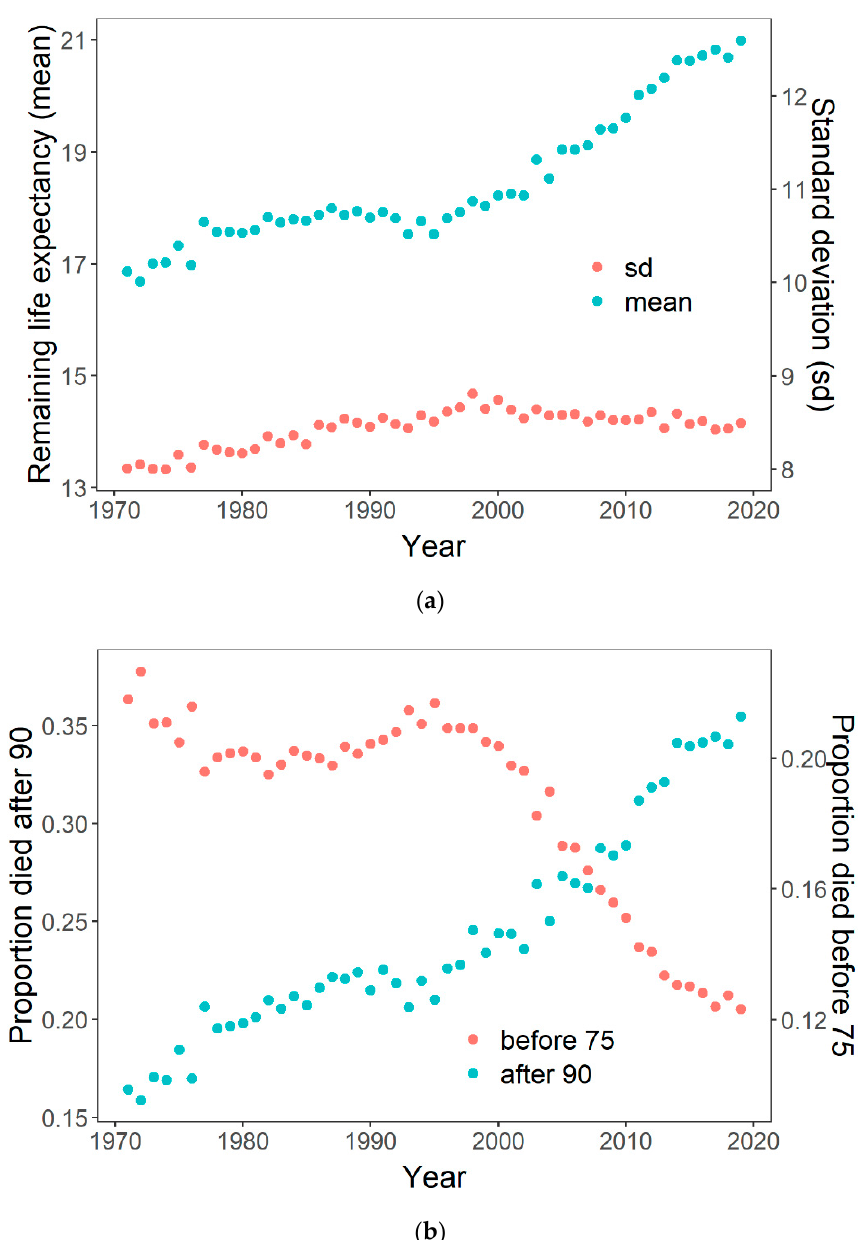
Figure 2. Life expectancy at age 65 for Danish females rose modestly 1970–2000, while lifespan inequality increased as well ( a ). The latter was due to the fact that a large proportion of the population continued to die before age 75, while an increasing proportion survived to higher ages ( b ).